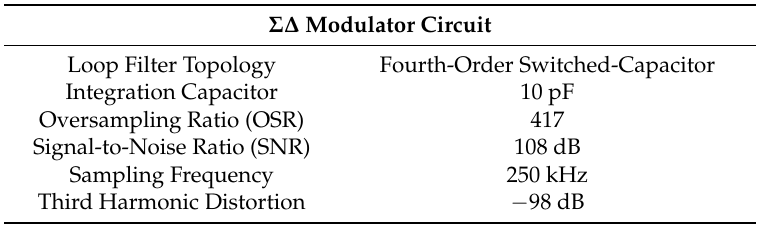
Table 2. Parameters of the Σ∆ modulator